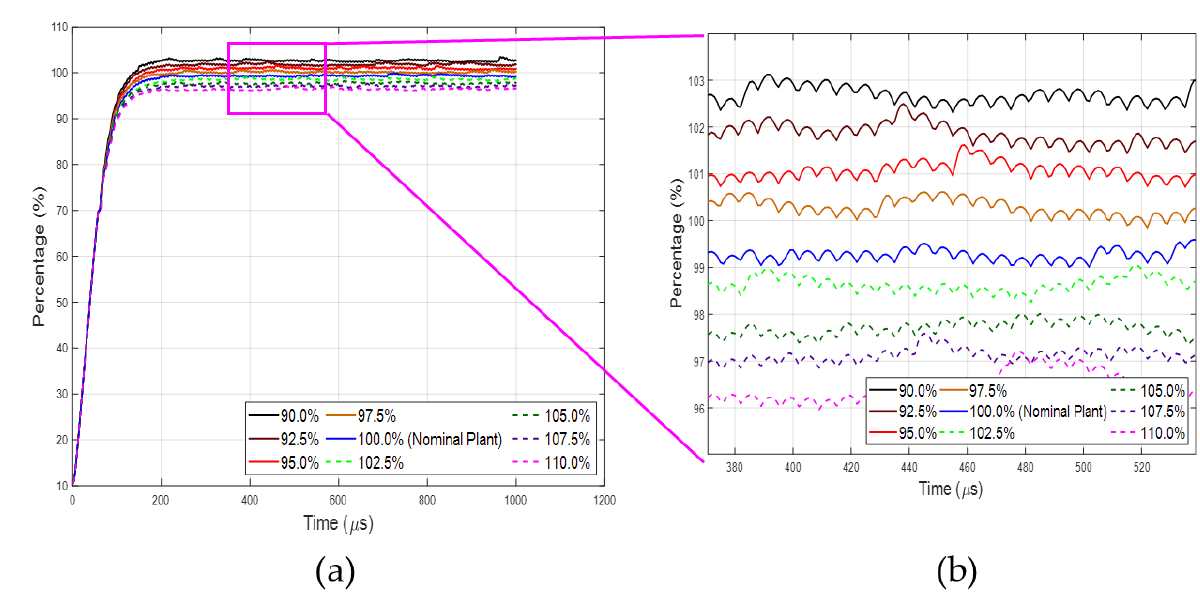
Figure 12. Responses under differentiation in material properties ( a ), close-up ( b ).